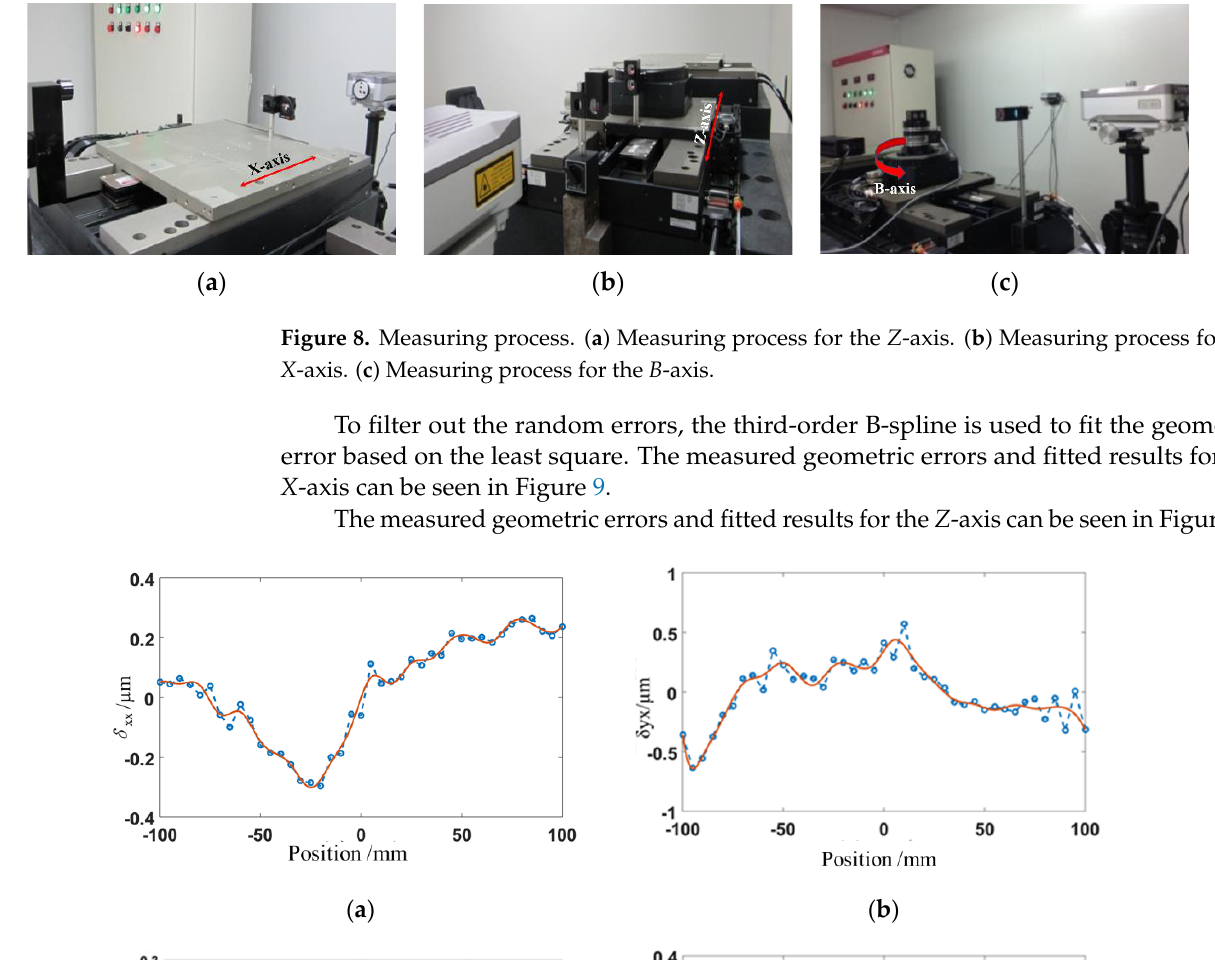
( d ) Figure 7. Axis position obtained from theoretical kinematic structure: ( a ) X − axis position, ( b ) Z − axis